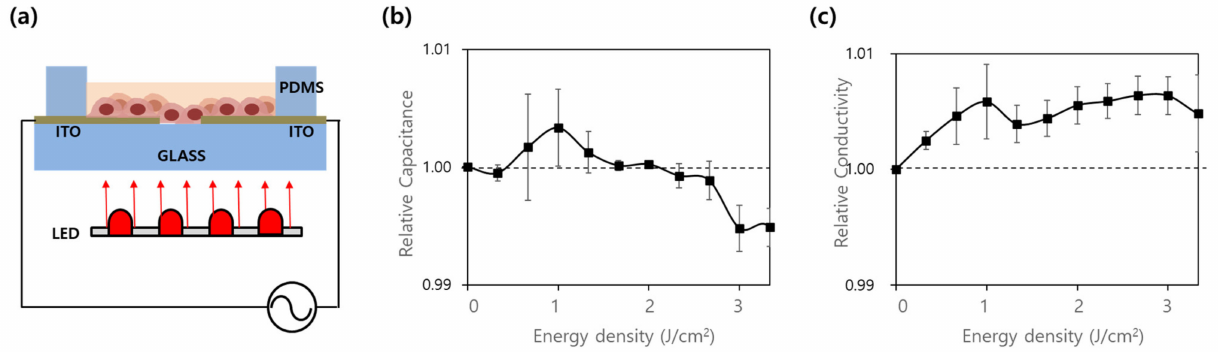
Figure 4. Capacitance and conductivity changes of the cells with NIR irradiation. ( a ) Schematics of impedance measurement of cell-cultured ITO glass device. ( b ) Relative capacitance changes with irradiation time. ( c ) Relative capacitance changes with irradiation